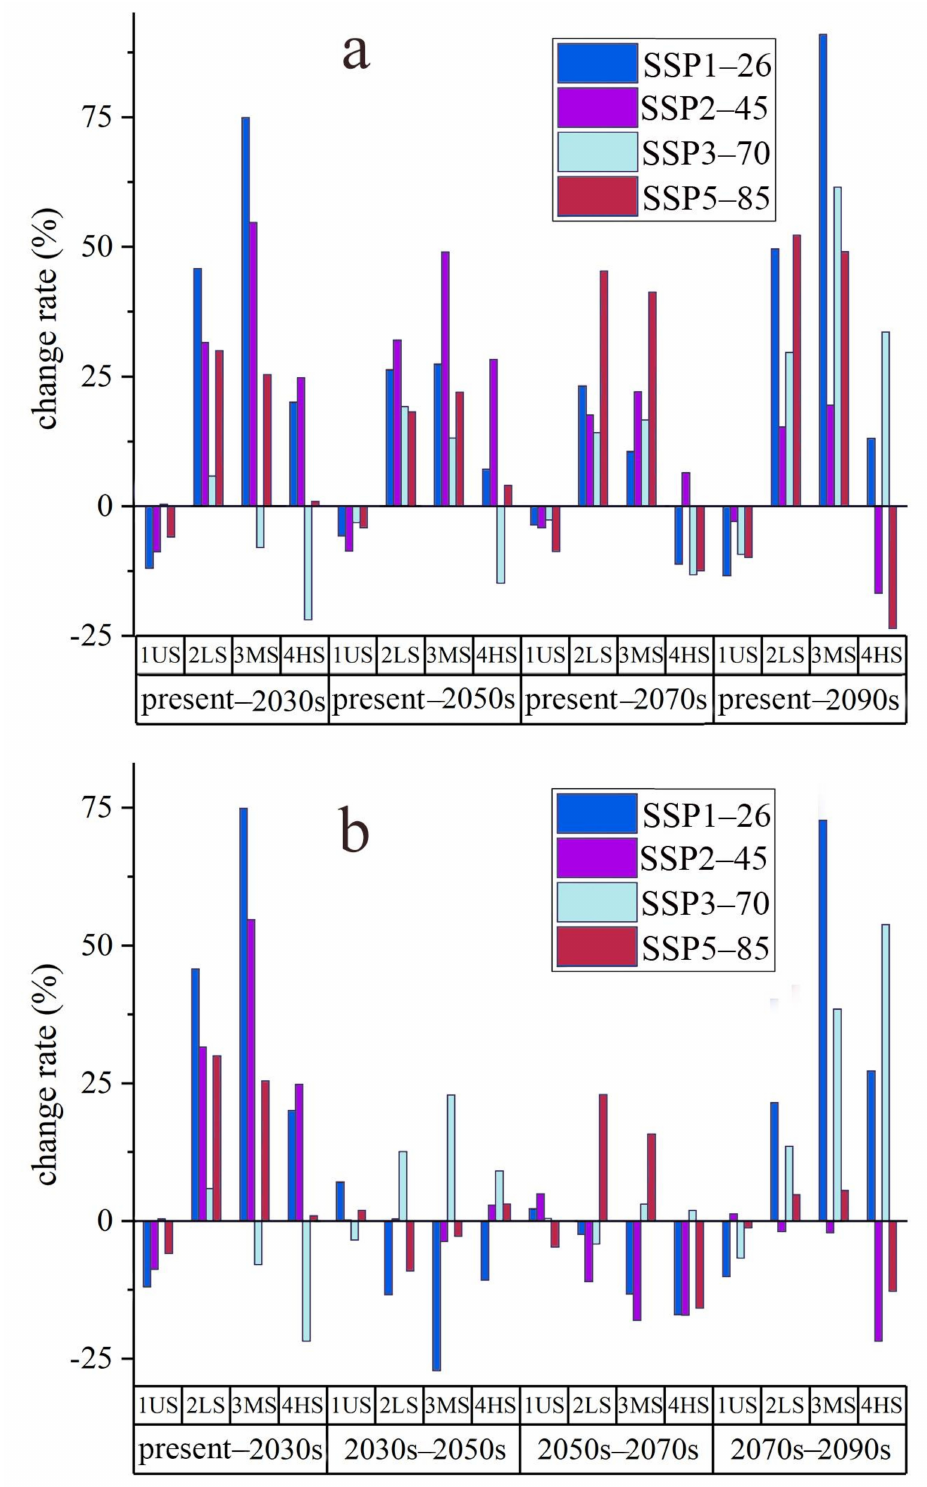
Figure 5. Habitat area change ratio of future–present ( a ) and 20–year equal intervals ( b ). The US LS, MS, and HS represent the suitability of unsuitable, low suitable, moderately suitable, and highly suitable, respectively. The formulas with “–” represent the intervals of change ratio (i.e., present–2030s represents the period from the present to the 2030s). The Shared Socioeconomic Pathways (SSPs) 1–26, SSP2–45, SSP3–70, and SSP5–85 represent four climate